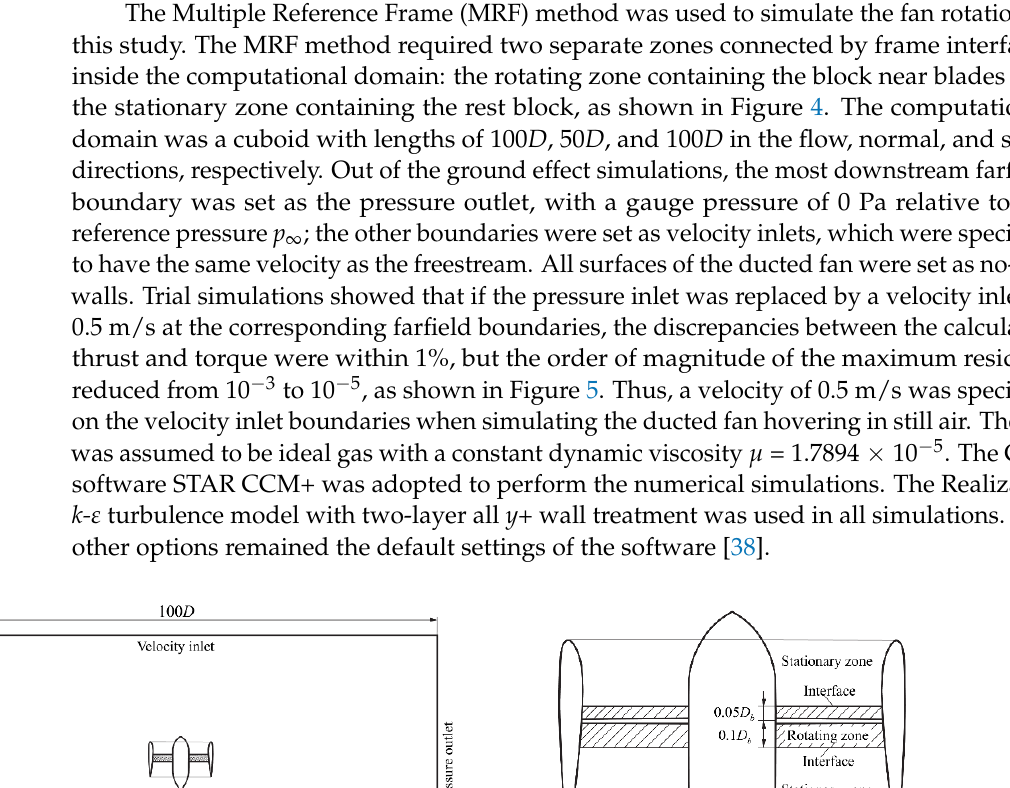
( b ) Figure 5. Comparison of results obtained with pressure inlet and velocity inlet boundary conditions: ( a ) force coefficients; ( b ) continuity residuals. The experiment conducted by Grunwald [9] was chosen for CFD validation, because the ducted fan studied in this paper has no experimental data yet. The ducted fan used in Grunwald’s experiment, hereafter labeled as Grunwald’s model, consists of a three-blade fan with a diameter of 0.381 m, a hub with a diameter of 0.109 m, and a duct with a chord length of 0.261 m. The tip clearance is 0.53% R b . Since the tip clearance is very small, to resolve it, the number of meshes as well as the difficulty of mesh generation is increased. According to the method proposed by Bunker [39], ignoring the tip clearance will overes- timate the ducted fan performance, in terms of propulsion efficiency, by about 0.9%. This discrepancy is acceptable for the present study. Therefore, the tip clearance is ignored in the subsequent simulations. To perform the grid independence study, three sets of poly- hedral meshes were generated: the coarse, medium, and fine mesh with 4.44 million, 8.86 million, and 16.6 million cells, respectively. The grid refinement was mainly performed on the ducted fan surfaces and the spherical region with a diameter of 5 D surrounding the ducted fan. The flowfield near walls was calculated by a wall function, and thus the first layer height of the grid was taken to make the y+ value between 30 and 200 [38]. The fan rotational speed was set to ω = 8000 rpm in simulations of Grunwald’s model. Firstly, the case of hovering was simulated. The thrust and torque coefficients calculated with different grid densities are plotted in Figure 6. The discrepancy between the torque coef- ficient calculated by the coarse mesh and that calculated by the medium mesh is 7.1%. However, the discrepancies between the coefficients calculated by the medium mesh and those calculated by the fine mesh are all within 1%. The comparison between the CFD results of the medium mesh and the experimental values is shown in Table 2. It can be seen that all discrepancies are within 8%, indicating that the CFD results agree well with